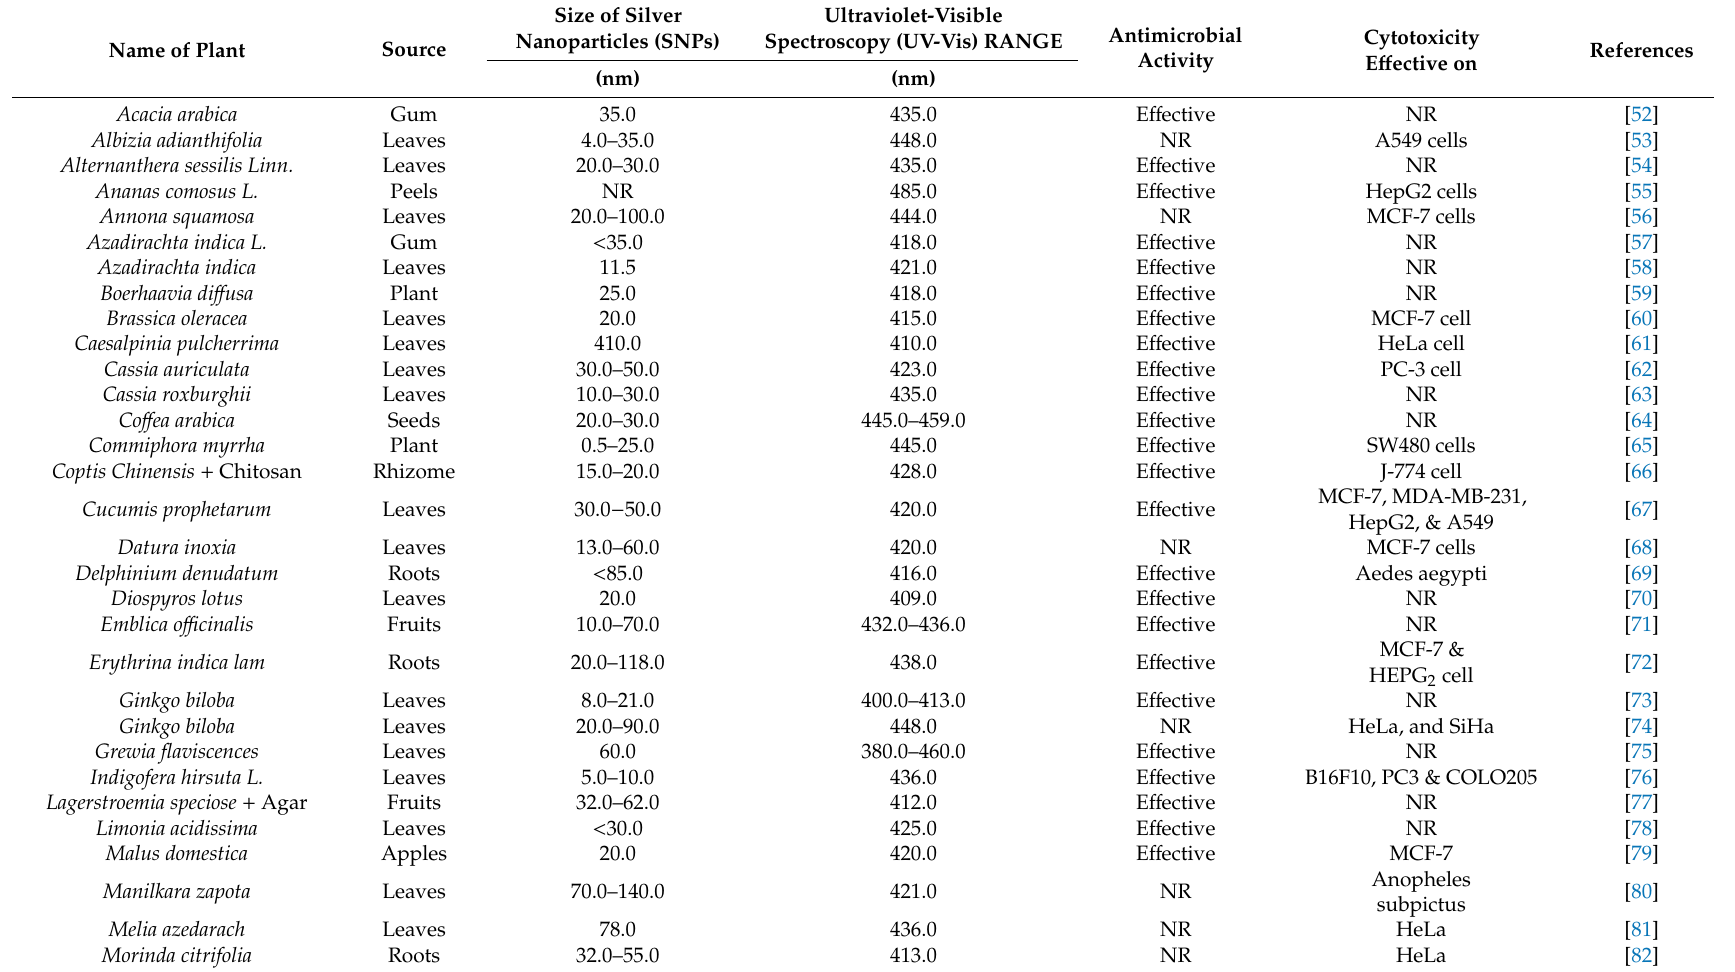
Table 1. Partial list of comparative parameters reported for plant extract mediated synthesis of